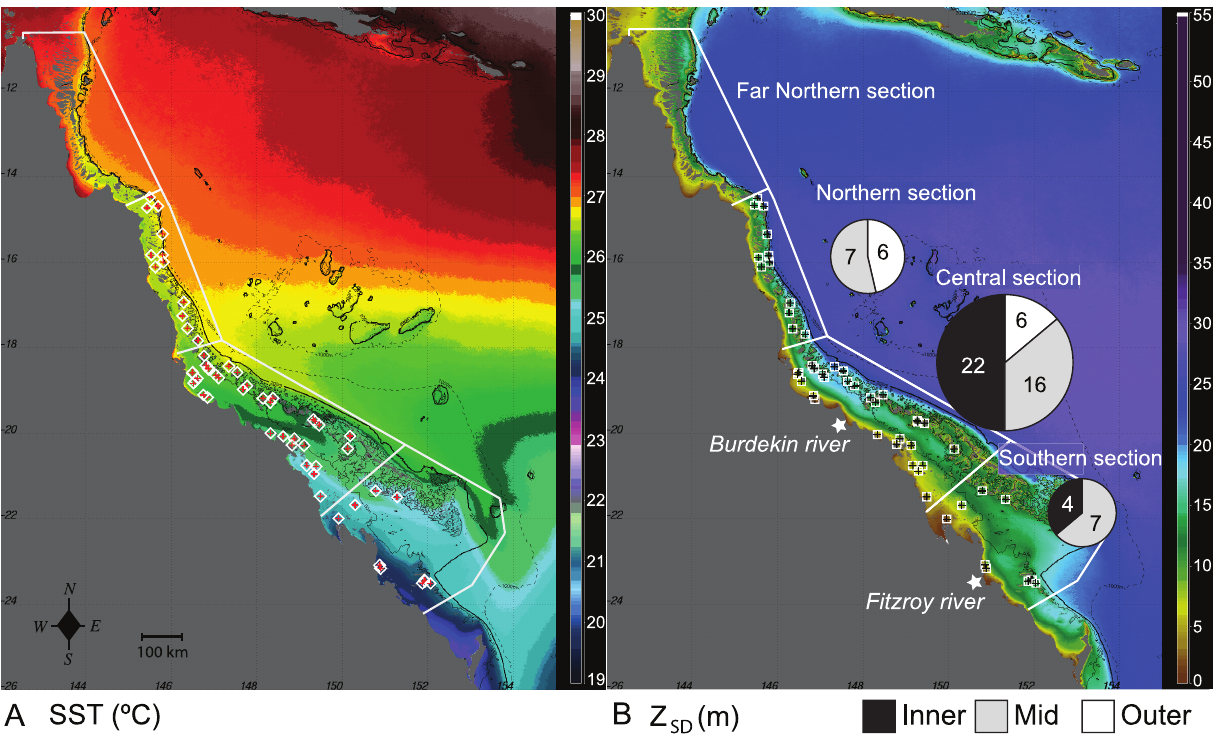
Figure 1. MODIS satellite images for the Great Barrier Reef. Long-term sea surface temperature climatology (SST, u C) (A) and Secchi depth climatology (Z SD , m) (B). Sites are indicated with crosses. Pie charts represent shelf position (inner, mid and outer) of collection sites for each section of the Great Barrier